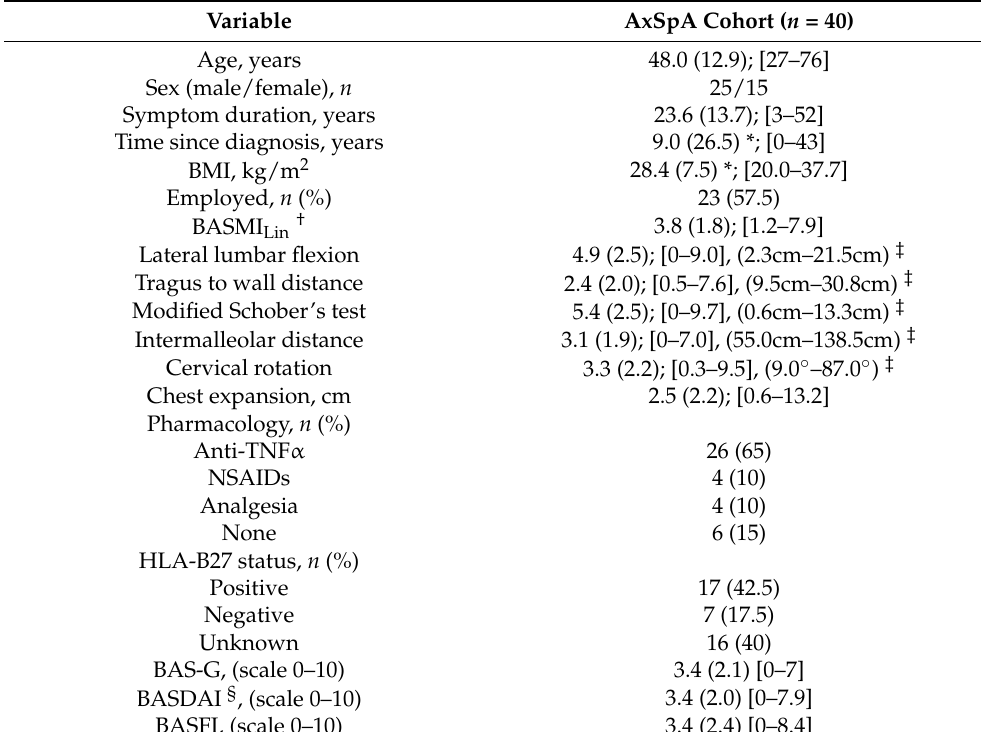
Figure 2. Participant recruitment. Table 2. Descriptive characteristics of study